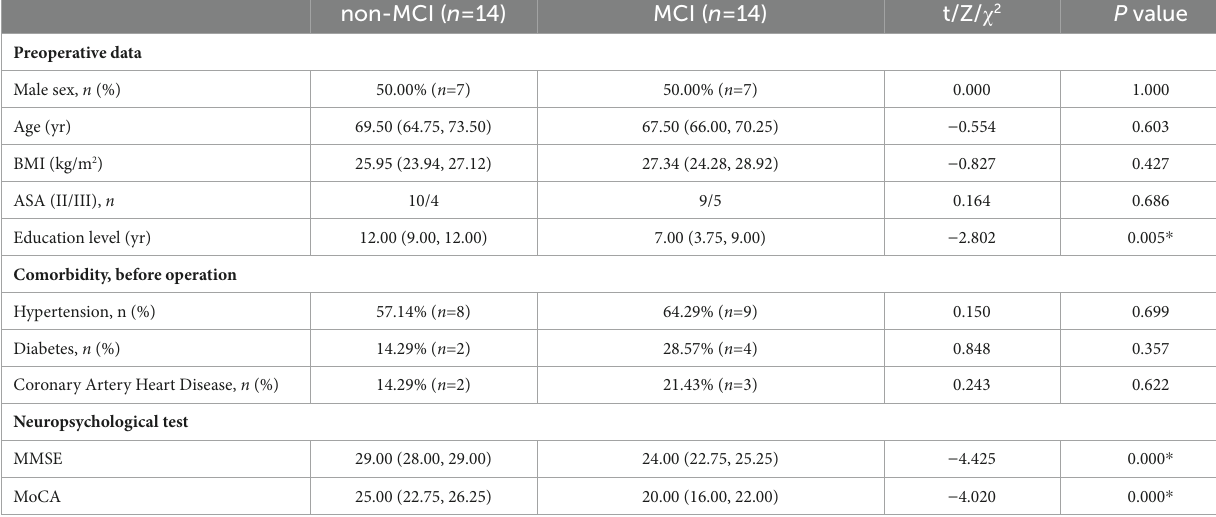
TABLE 2 Demographic data for patients with/without